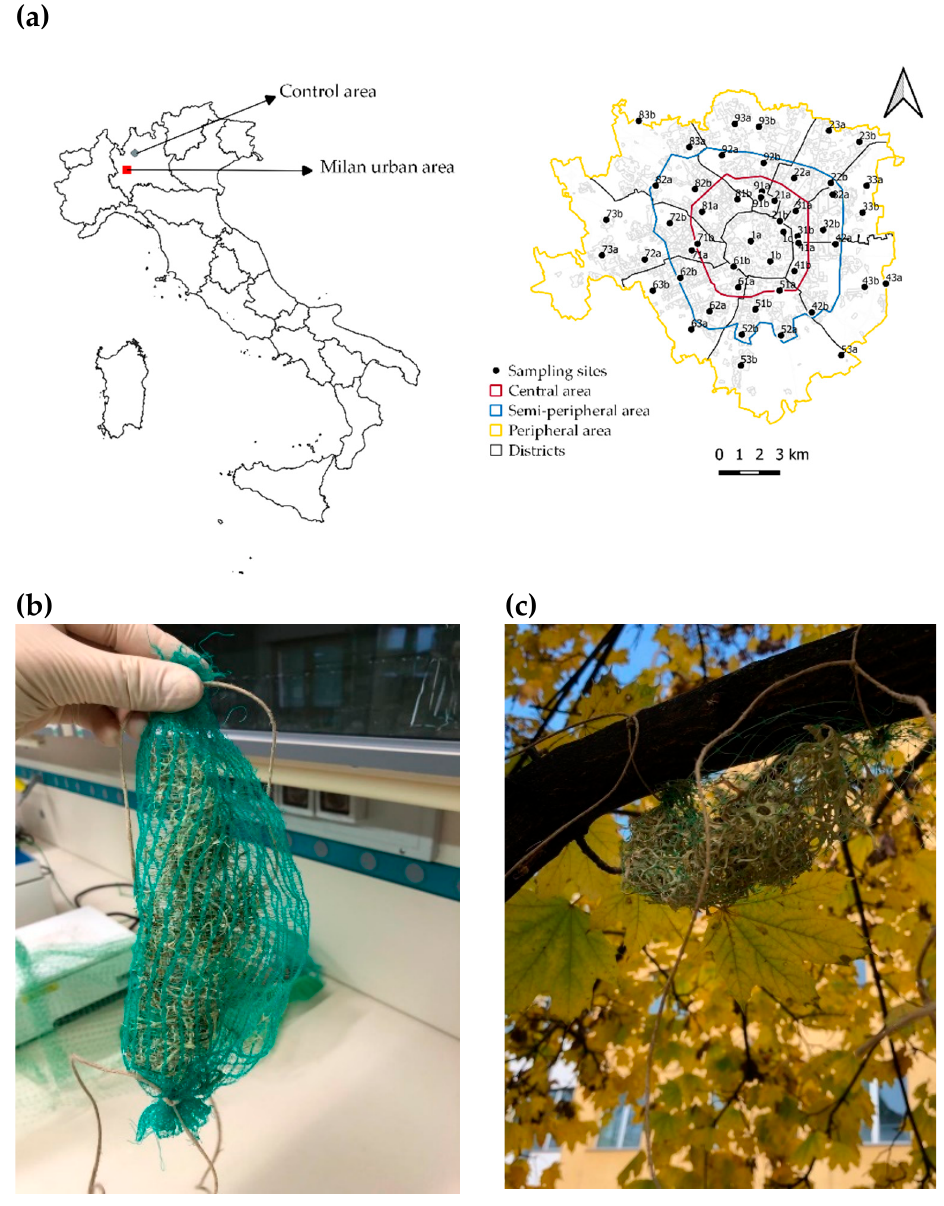
Figure 1. ( a ) Study area with indication of sampling sites. Milan municipality is represented with the three concentric belts designed for the stratified sampling design. The red square on the map of Italy (left side) indicates the location of Milan municipality; ( b ) A lichen-bag before the exposure; ( c ) a lichen bag transplanted in the study area.